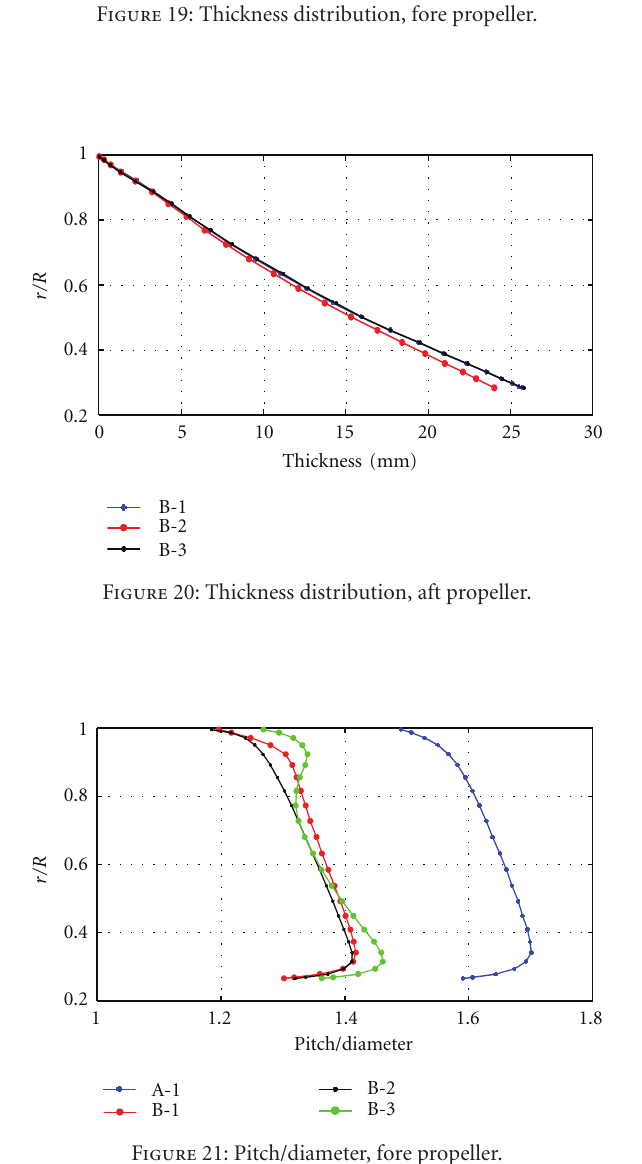
Figure 19: Thickness distribution, fore propeller.